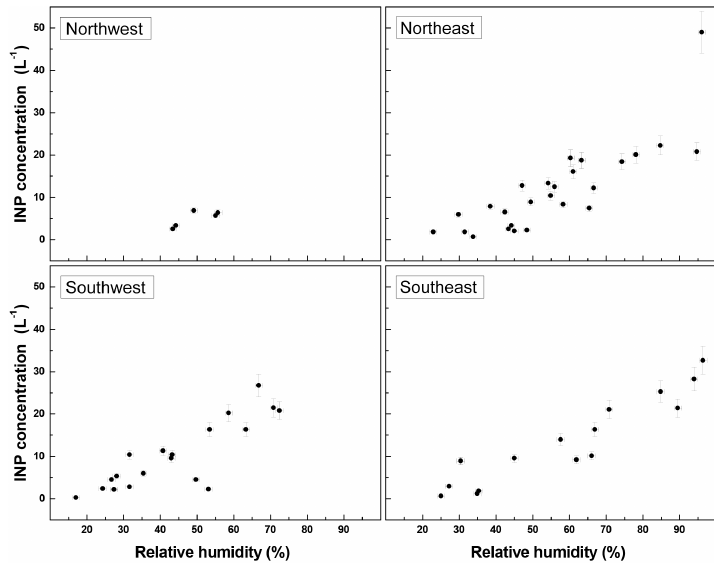
Figure 5. INP concentrations at different ambient relative humidity for the different origins of the air